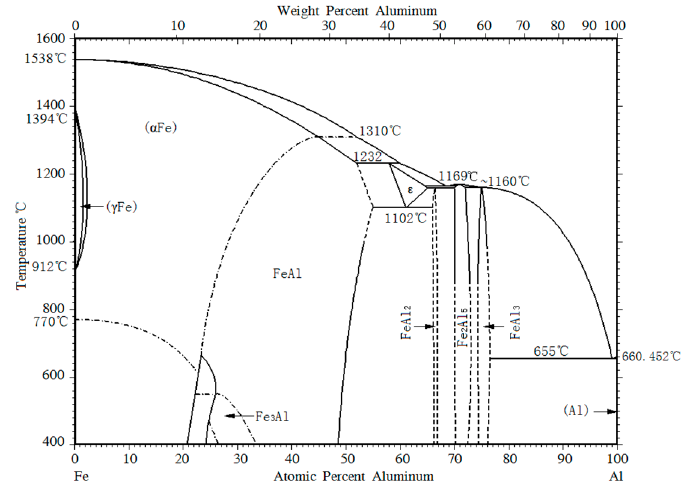
Figure 7. The phase diagram of the Al-Fe binary alloy.